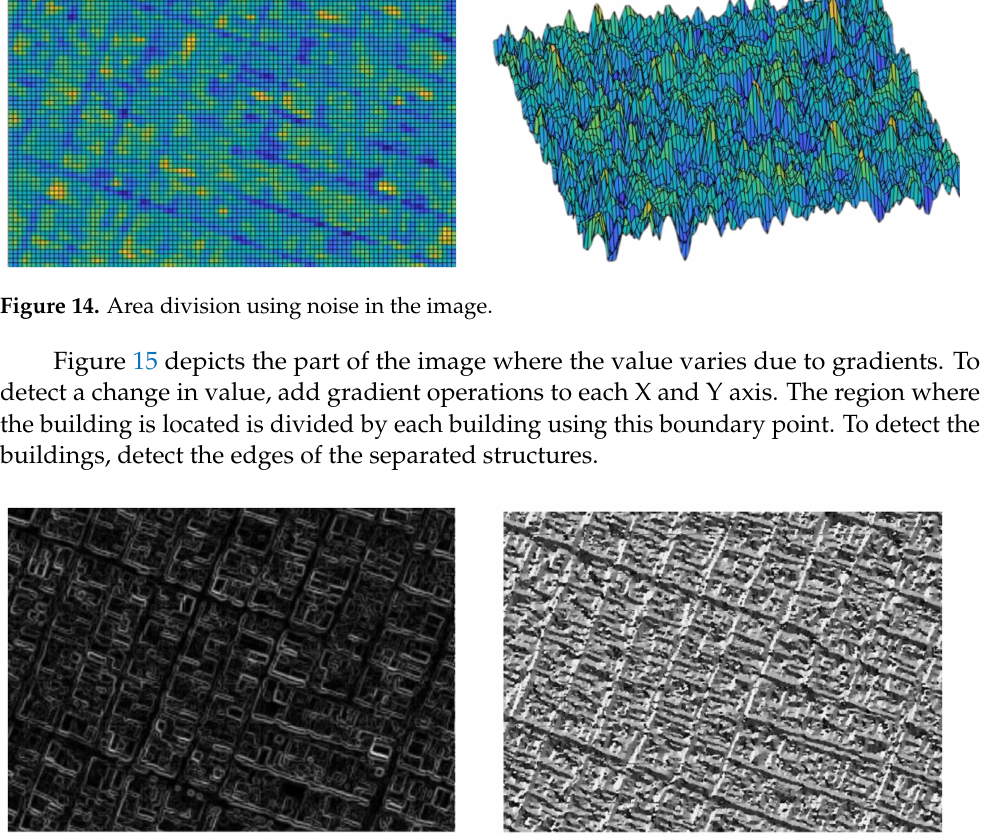
Figure 15. Area division using noise in the image.